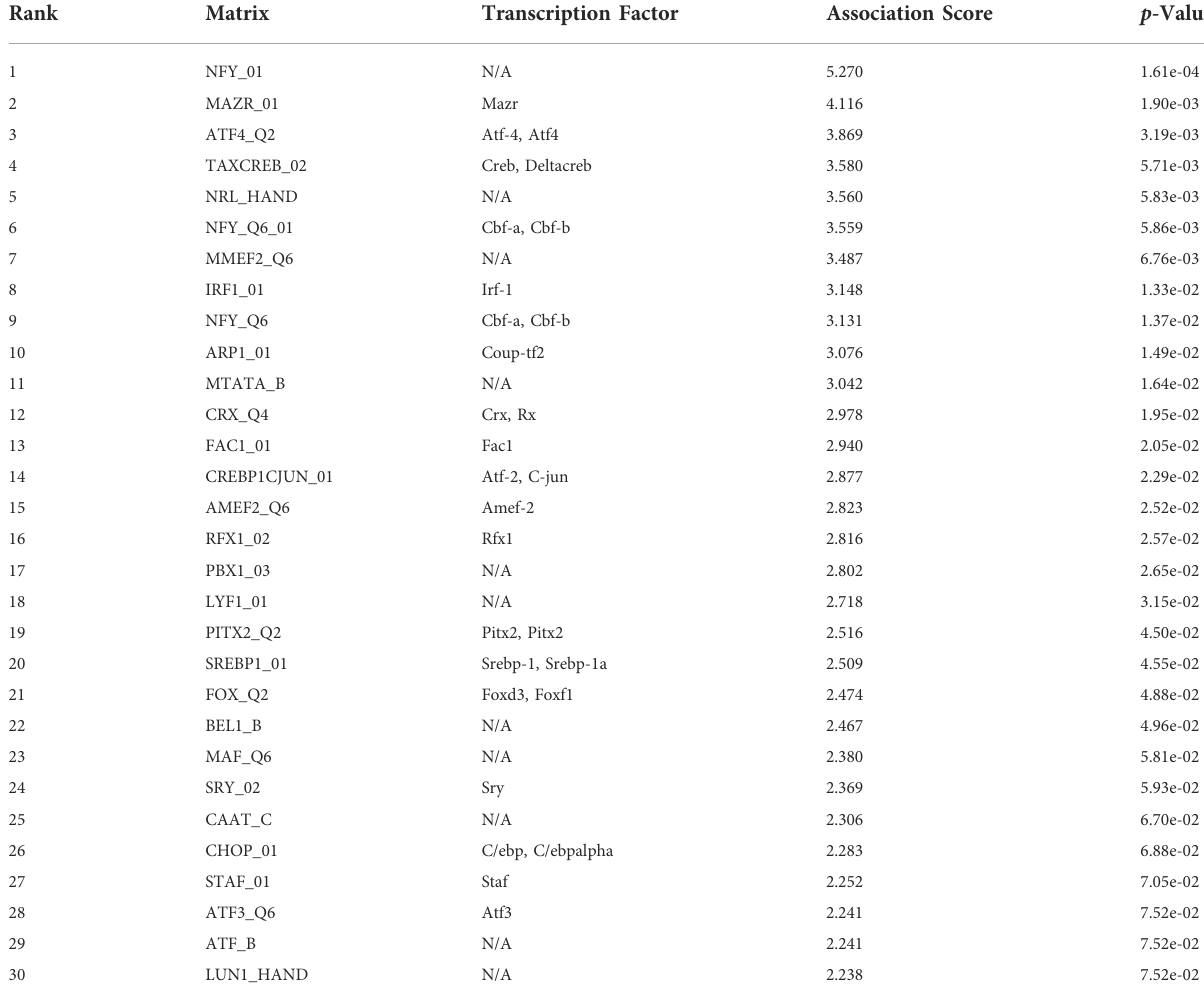
TABLE 2 The top 30 transcription factor of 93 ferroptosis-related genes from PASTAA. Rank